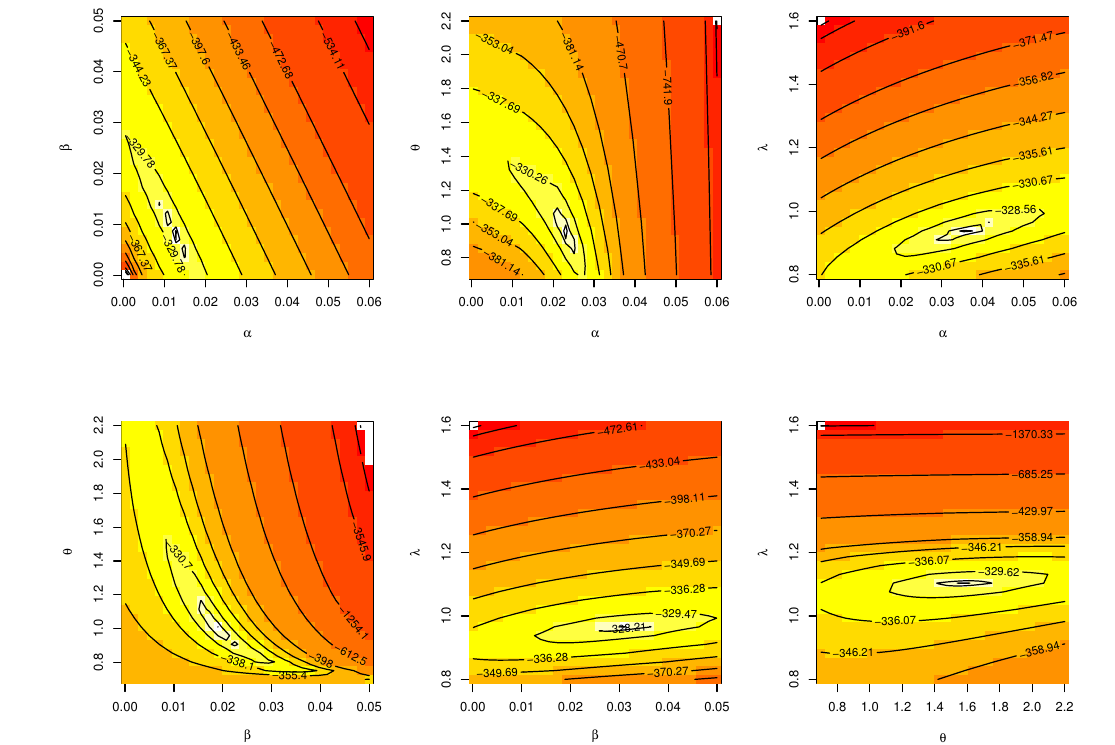
Figure 8. Contour plot for parameters of TLMW model for COVID-19 data.